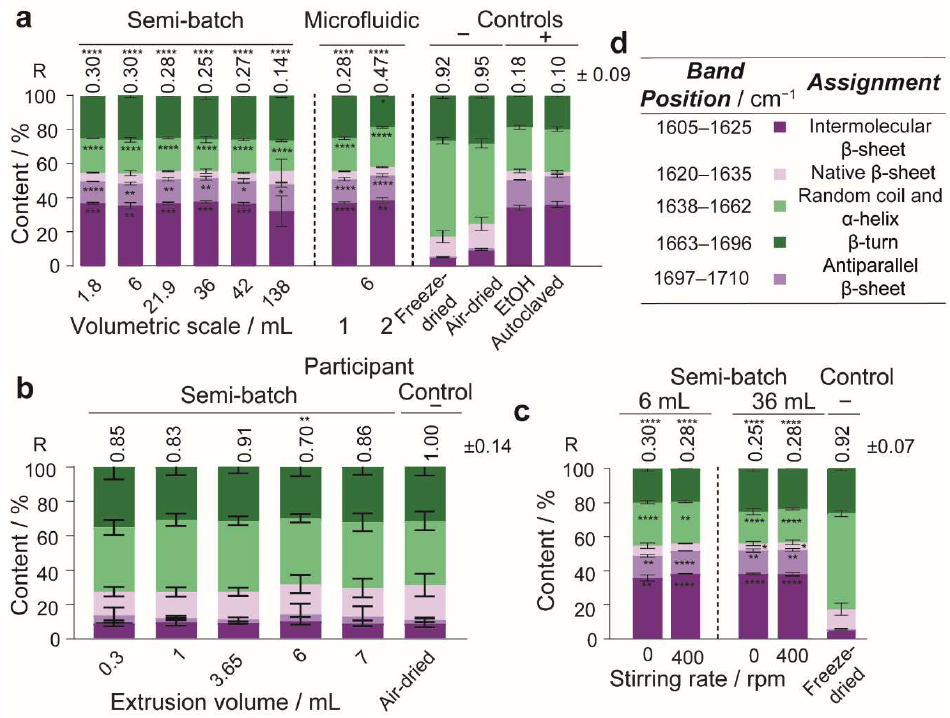
Figure 5. The total β-sheet content of silk nanoparticles did not vary significantly with volumetric scale when prepared by semi-batch format. FTIR secondary structure content (%) of ( a ) silk nanoparticles manufactured using different volumetric scales and formats of manufacture, ( b ) silk precursor extruded from the semi-batch open system feed needles, ( c ) silk nanoparticles manufactured using different volumetric scales and stirring rates, and ( d ) key for FTIR band assignments. The relative area of the assigned peaks in the second derivative spectrum were used to calculate the secondary structure content (%). The positive silk II controls were defined as the 70% v / v ethanol/ultrapure H 2 O annealed and the autoclaved silk films. The negative silk II controls were defined as the air-dried silk film and freeze-dried silk powder. The negative silk II control (air-dried film) was defined as the reference for the spectral correlation coefficients of all sample types. For nanoparticles manufactured at different volumetric scales, the total β -sheet, β -turn, α -helix, and random coil contents and the correlation coefficients were evaluated using the one-way ANOVA tests against the negative silk II control (freeze-dried powder) followed by the Dunnett T3 multiple comparison post hoc test. For the microfluidic format, the nanoparticle correlation coefficients, total β -sheet, β -turn, α -helix, random coil, and anti-parallel β -sheet contents were evaluated by one-way ANOVA against the negative silk II control (freeze-dried powder) followed by Dunnett’s multiple comparison post hoc test. For nanoparticles manufactured at a 6-mL scale with and without stirring, the correlation coefficients, total β -sheet, and β -turn values were evaluated by one-way ANOVA against the negative silk II control (freeze-dried powder) followed by Dunnett’s multiple comparison post hoc test. For nanoparticles manufactured at a 36-mL scale with and without stirring, the correlation coefficients, α -helix, and random coil contents and β -turn and native β -sheet values were evaluated by one-way ANOVA against the negative silk II control (freeze-dried powder) followed by Dunnett’s multiple comparison post hoc test. The remaining contents were evaluated using the Brown–Forsythe and Welch ANOVA tests. Data ( ± SD, n = 3) obtained from semi-batch manufacture at the 6-mL scale and the stirred 36-mL scale [30], silk II controls [30], and from participant 2 in the microfluidic format [43] were published elsewhere. Multiple groups of a silk precursor extruded with varying volume ( ± SD, n = 9) were evaluated by the Brown–Forsythe and Welch ANOVA against the negative silk II control (air-dried film) followed by the Dunnett T3 multiple comparison post hoc test. Asterisks denote statistical significance determined using post hoc tests as follows: * p < 0.05, ** p < 0.01, *** p < 0.001, and **** p <